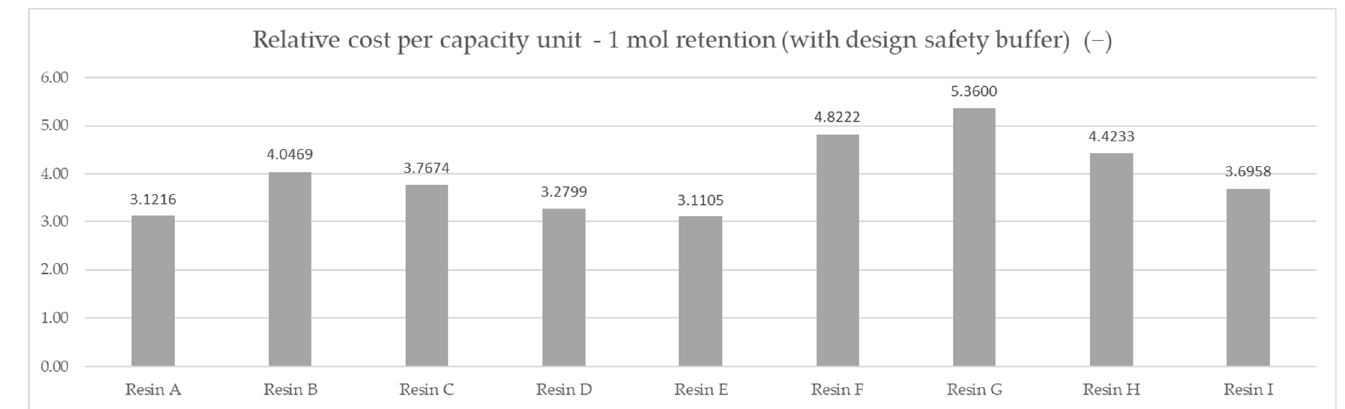
Figure 10. Comparison of the test-derived safety buffer required to ensure a repeatable efficiency for the tests, according to the Six Sigma methodology.